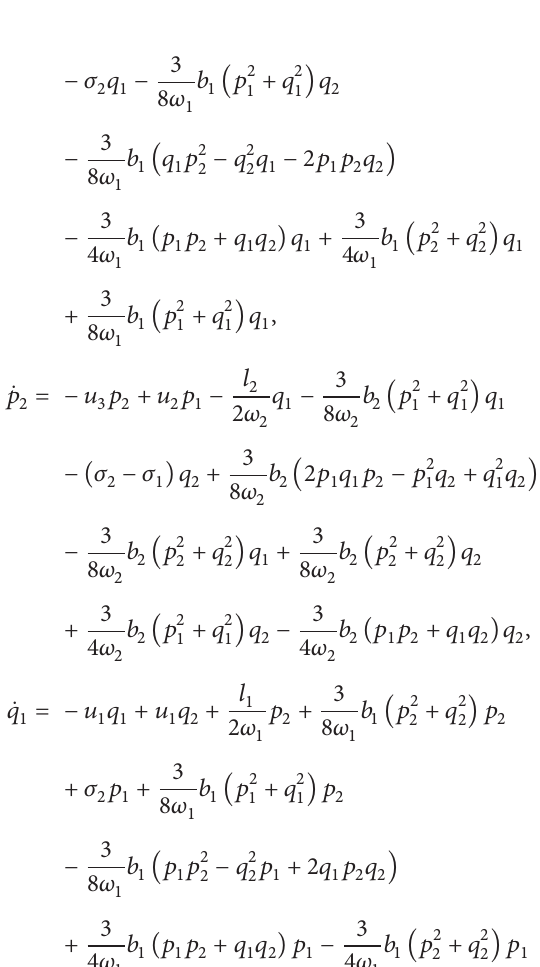
Figure 5: Amplitude-frequency